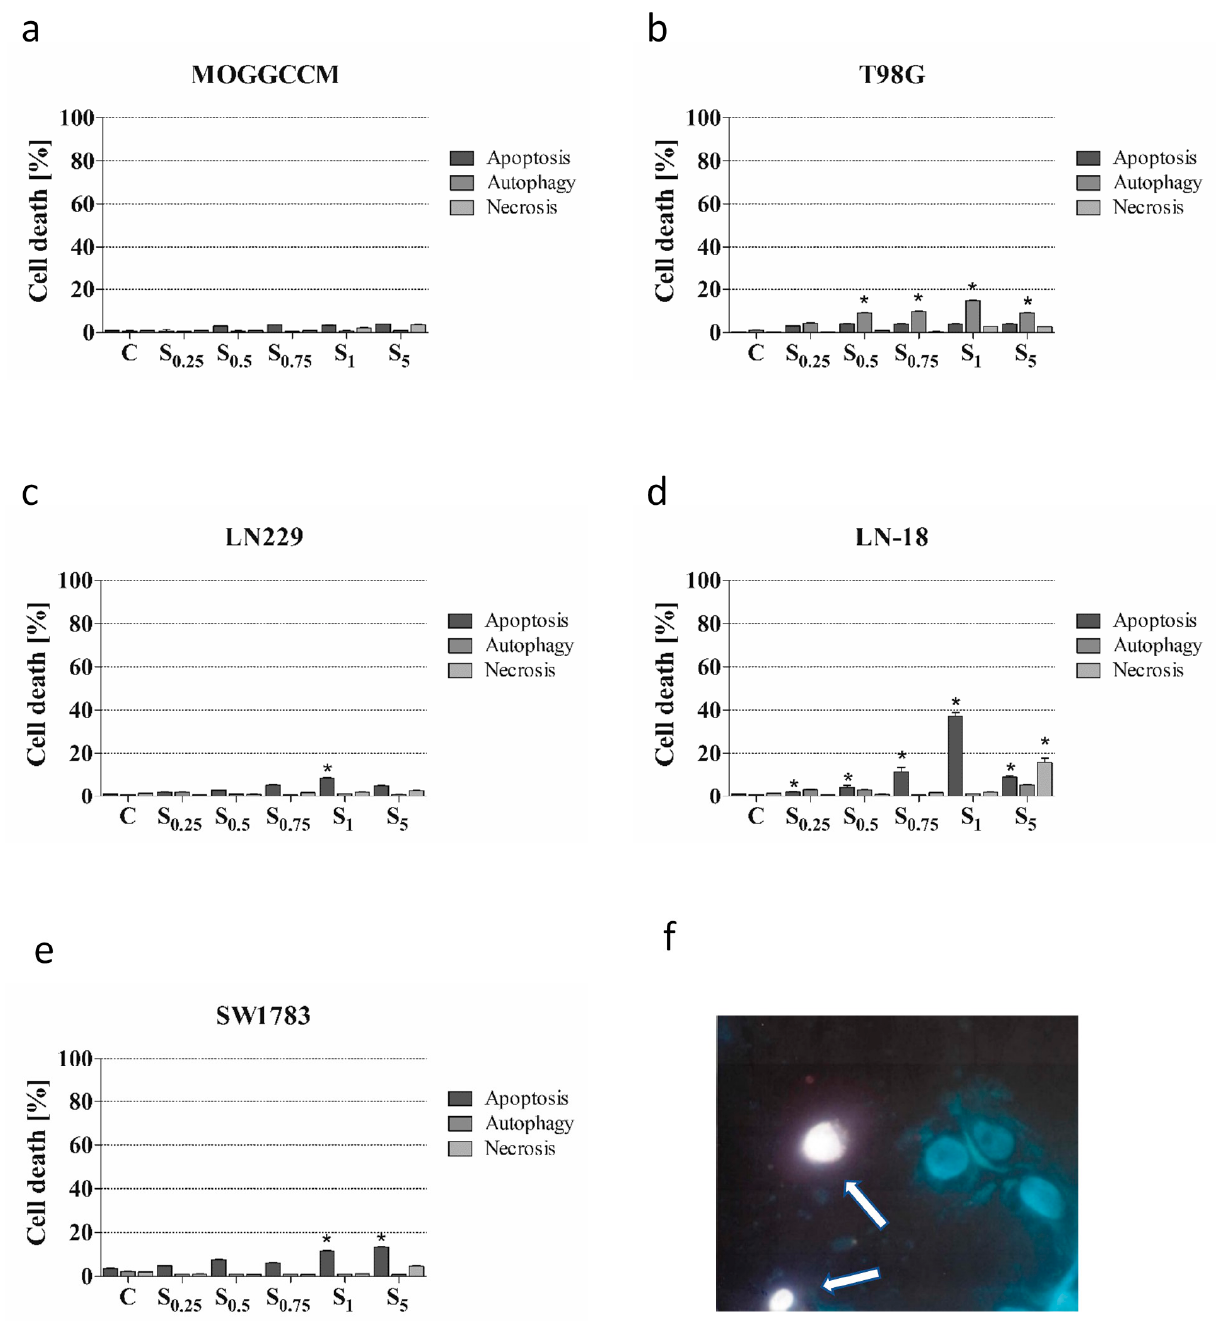
Figure 2. Effect of sorafenib on the level of apoptosis, autophagy, and necrosis, identified microscopically after staining with Hoechst 33342, acridine orange, and propidium iodide, respectively, in anaplastic astrocytoma (MOGGCCM, LN229, SW1783; ( a , c , e )) and glioblastoma multiforme cells (T98G, LN-18; ( b , d , f )) incubated with the compound for 24 h. ( f ) Representative picture of necrotic LN-18 cells (pointed by arrows) stained with propidium iodide after 5 µ M sorafenib treatment; C—control; * p < 0.01 compared to the